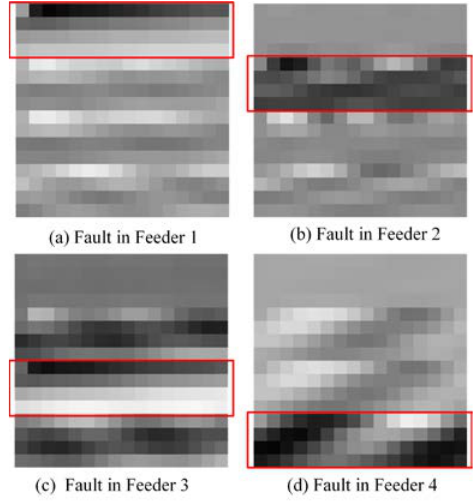
Figure 9. Grayscale images of the system with different feeder